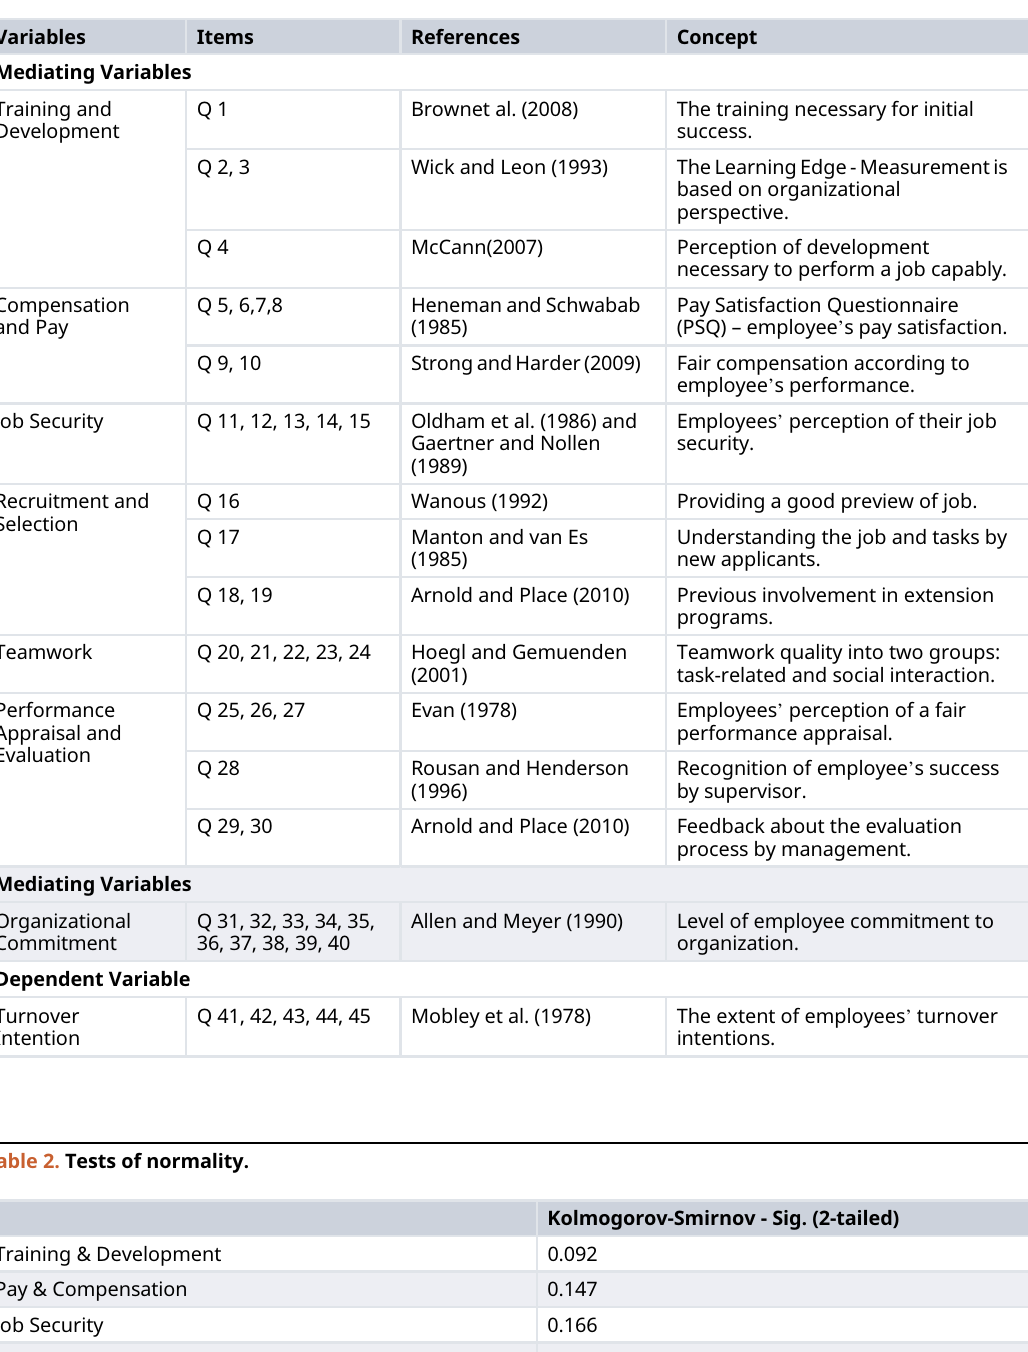
Table 1. Sources of questions in section B.